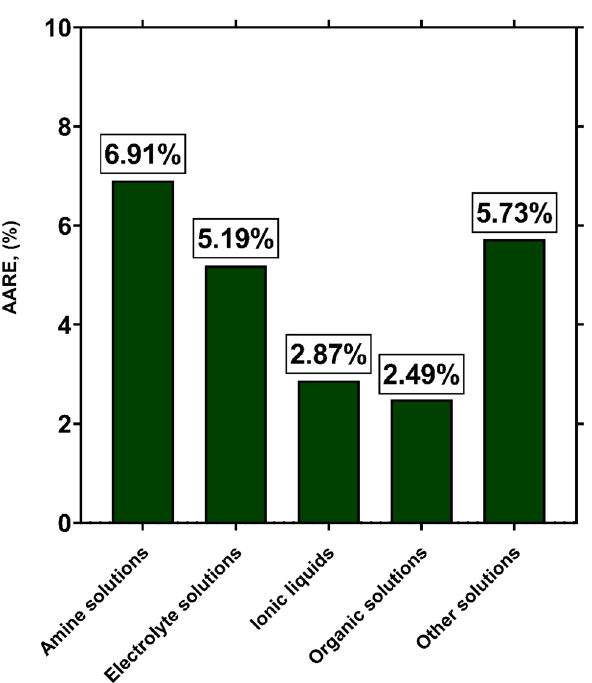
Figure 6. AARE values corresponding to GPR model for predicting H 2 S solubility in various types of solvents (created by GraphPad 8.4.3.686 145